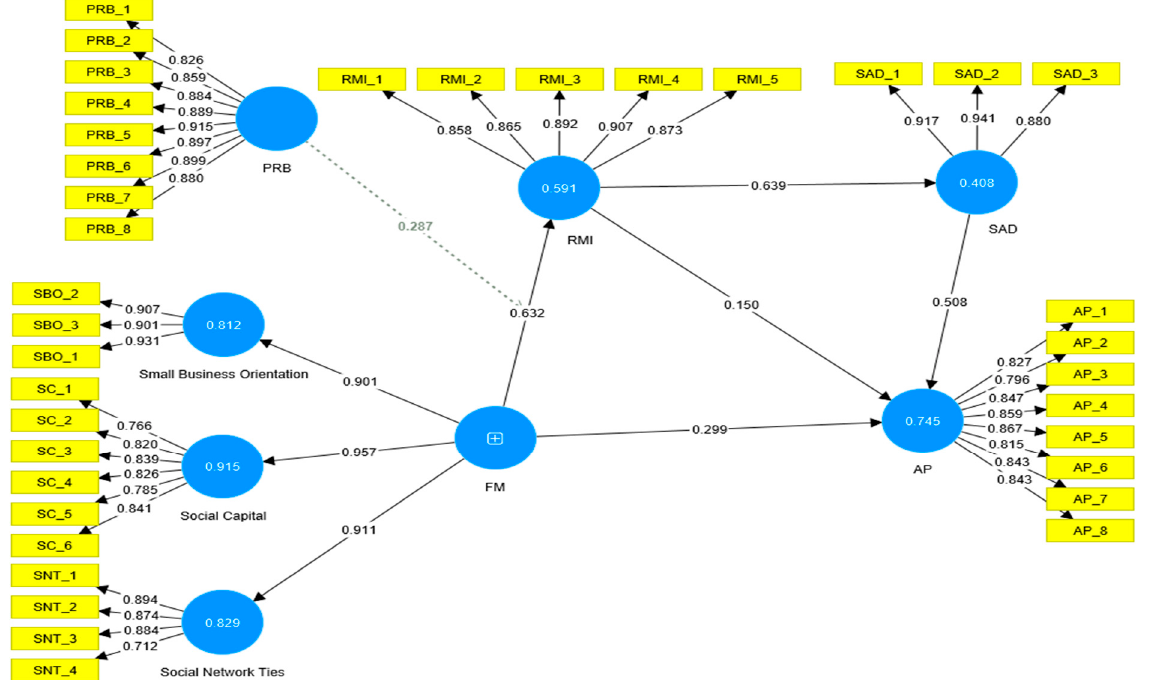
Figure 3. The tested structural and measurement model. FM: family micro-business resources, AP: